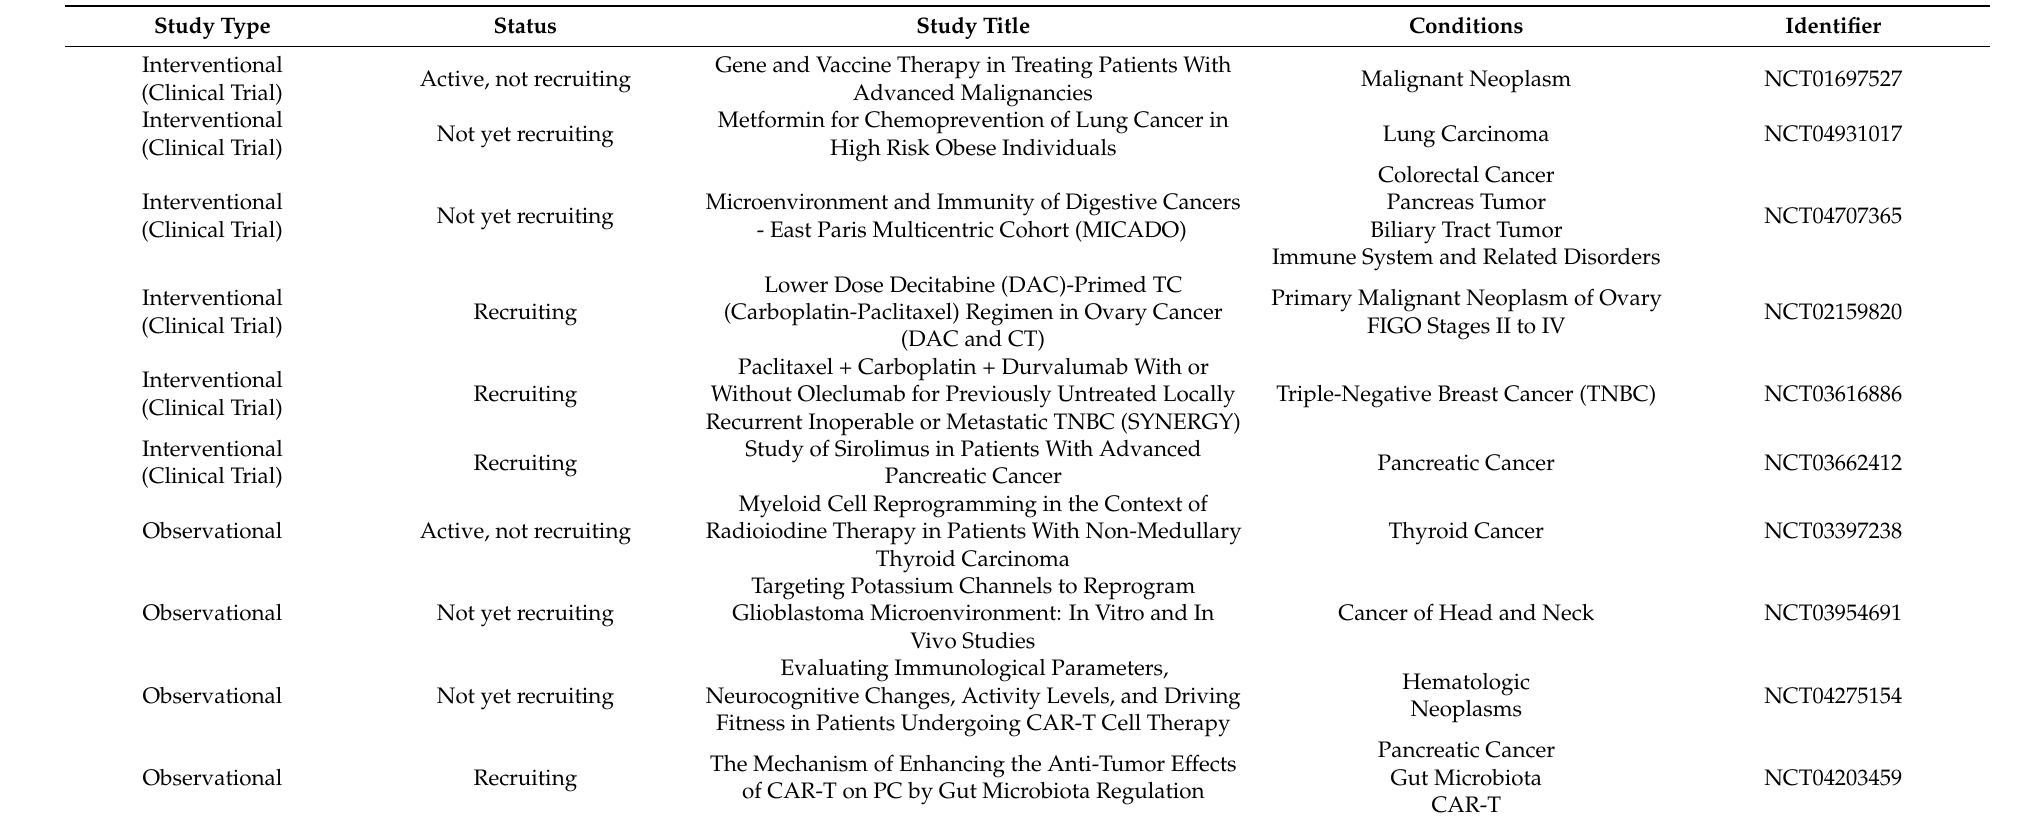
Table 1. Therapeutic application of immunometabolism regulation. Forty studies related to immunometabolism regulation in cancer were found in clinicaltrials.gov database (accessed on 15 June 2021) using the following Boolean search string: “(immune AND reprogramming) OR (regulation AND metabolism AND immune) OR (immunotherapy AND metabolism AND modulation)”. Here are summarized 10 of the most representative current studies in the